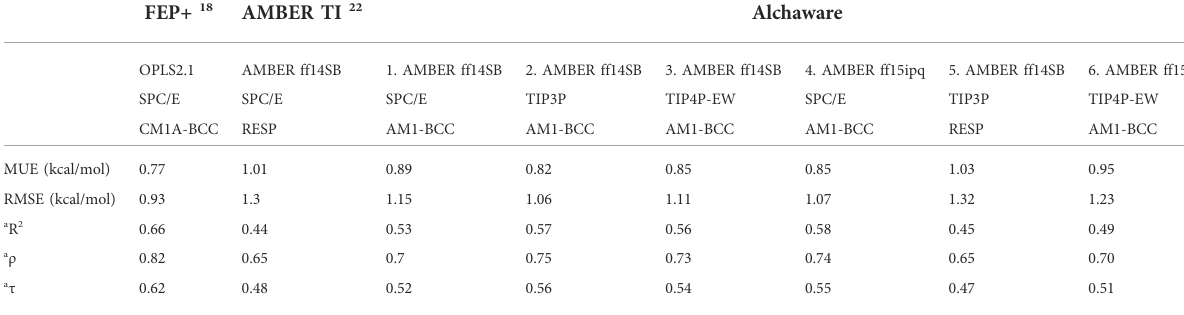
TABLE 2 Summary of accuracy and correlation statistic results of the fi ve parameter sets tested here alongside two published datasets.